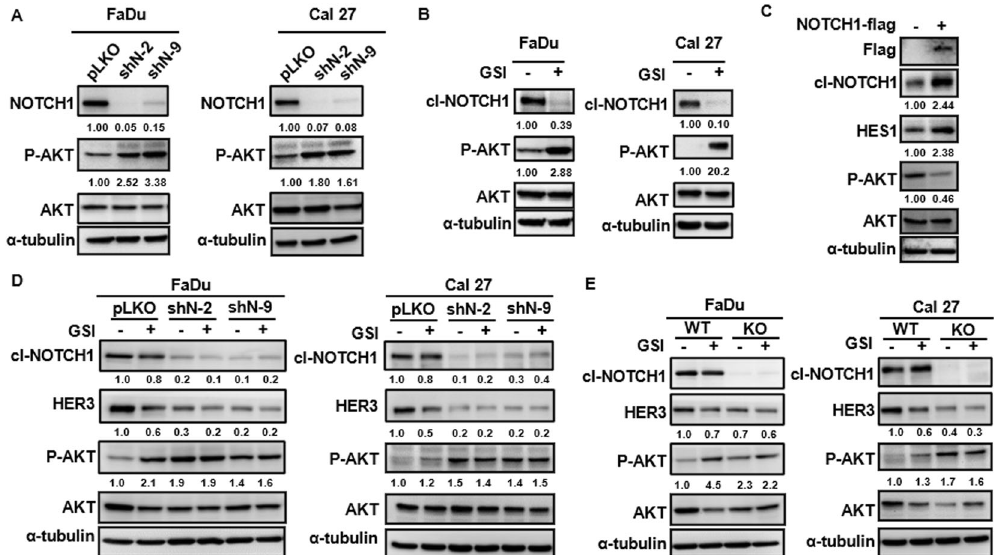
Fig. 2 NOTCH1 negatively regulates AKT in SCCHN cells. A Increased phosphorylation of AKT was observed in FaDu and Cal 27 cells after NOTCH1-knockdown with different shRNA constructs. B Phosphorylation of AKT was also enhanced by treatment with GSI in FaDu and Cal 27 cells. C Overexpression of NOTCH1 led to decreased phosphorylation of AKT in FaDu cells. D The addition of GSI to NOTCH1-knockdown FaDu and Cal 27 cells did not further boost the phosphorylation of AKT. E Phosphorylation of AKT remained the same in NOTCH1-knockout FaDu and Cal 27 cells after treatment with